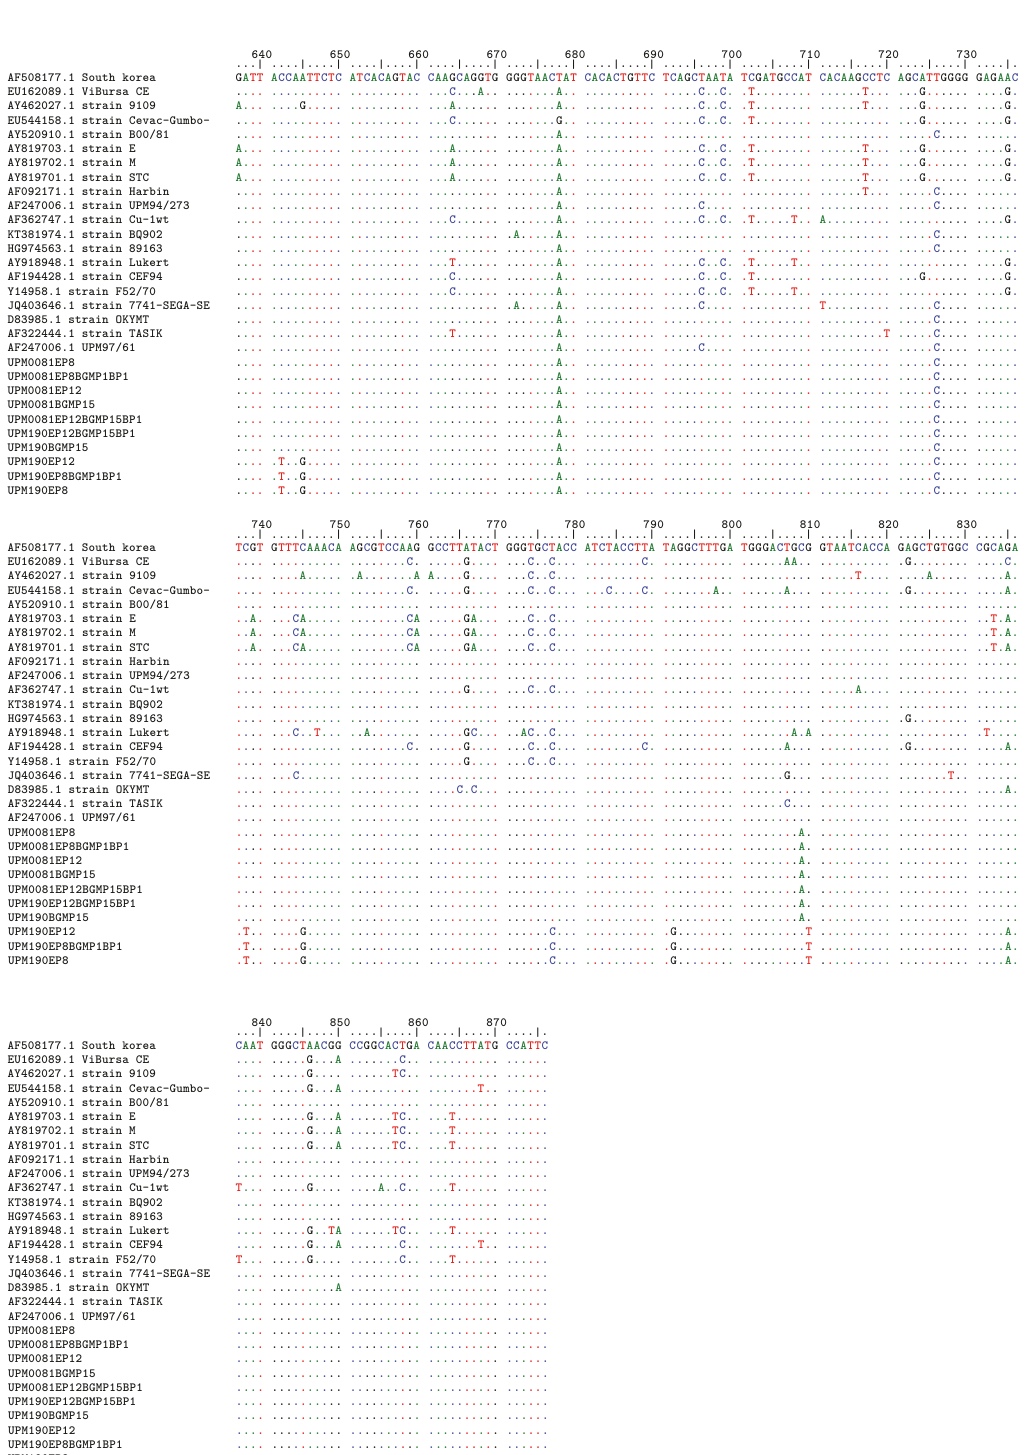
Figure 4: Comparison of nucleotide sequences of bioreactor, conventional flask, and CAM propagated UPM0081 and UPM190. Nucleotide alignment of bioreactor, BGM-70, and SPF egg UPM190 and UPM0081 isolates with 30 reference sequences showing no nucleotide changes between the original parent and the bioreactor passaged